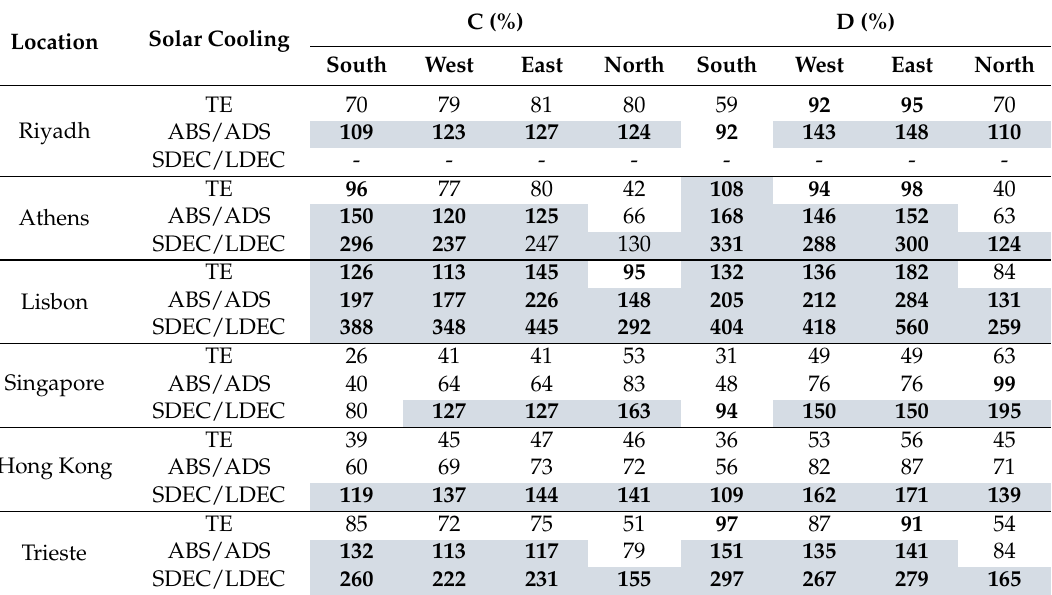
Table 9. Solar fraction for scenarios C and D in all locations and